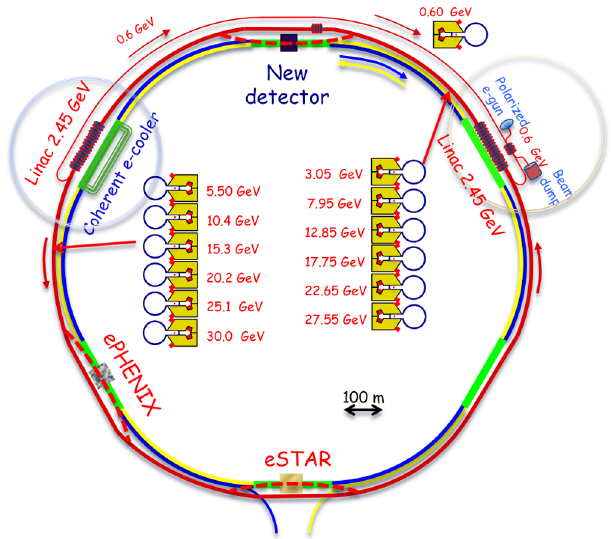
FIG. 1. eRHIC layout with a six pass ERL (beam travels counterclockwise). Electron beam is generated and preacceler- ated to 0.6 GeV before entering eRHIC’s main linacs located at 2 o’clock and 10 o’clock. The e-beam gains 2.45 GeV of beam energy in each linac (as labeled) and reaches to its top energy at 30 GeV in six passes. For FEL operation, the bunch compressor will be located at 12 o’clock.